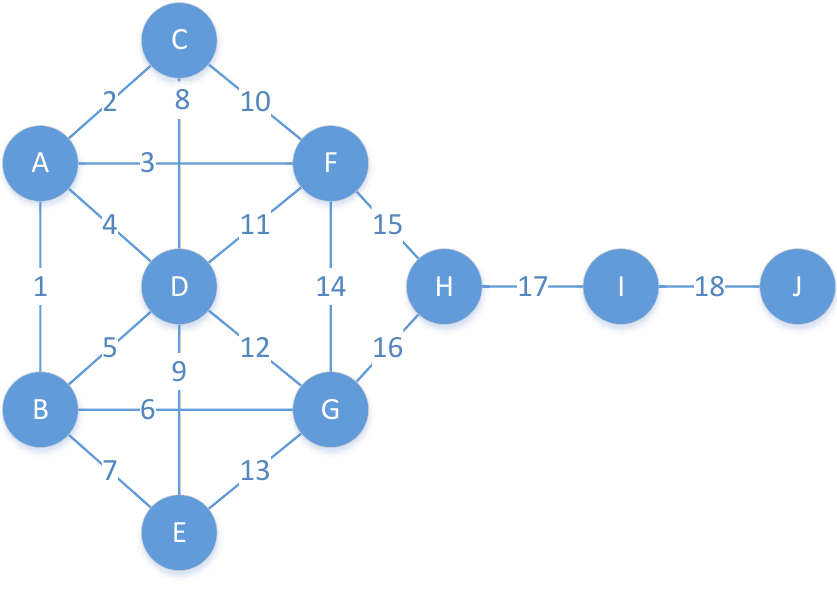
Figure 1. Kite network